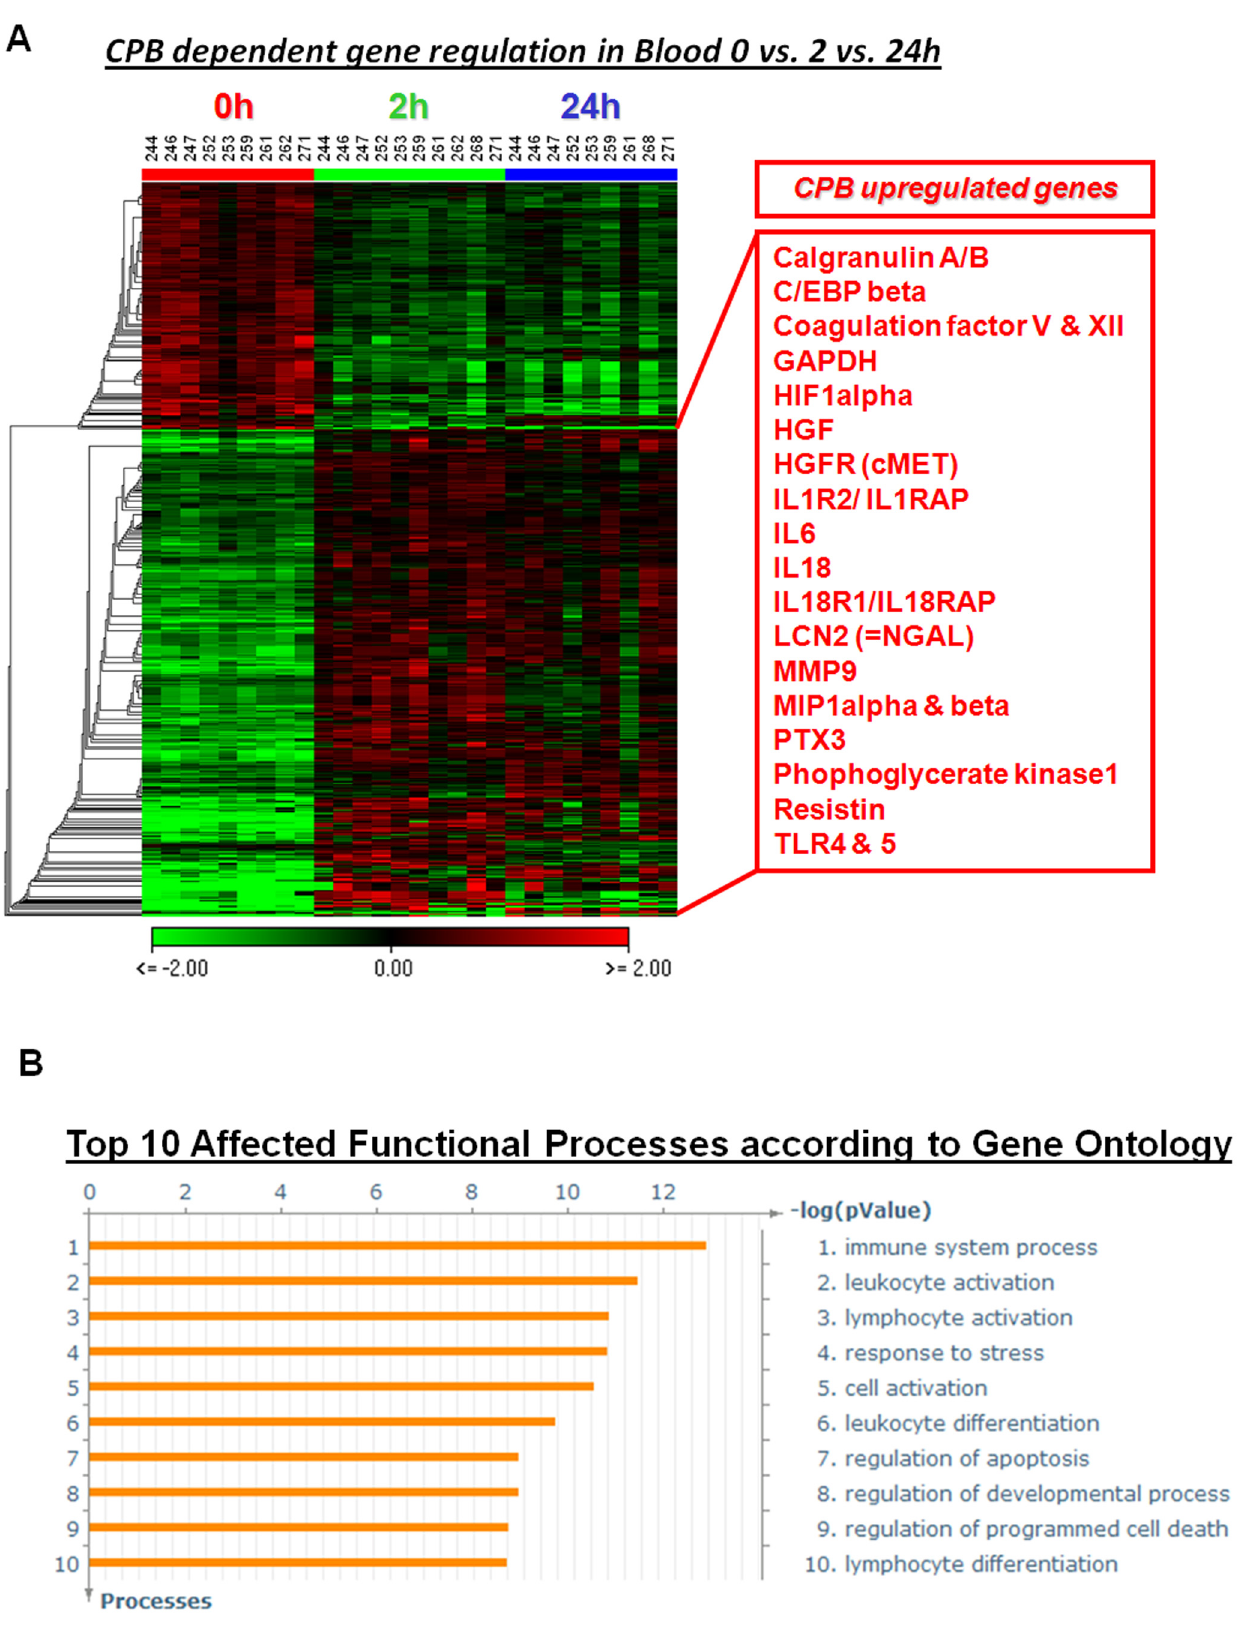
Figure 1. Genome-wide expression profiling. Wholebloodgeneexpressionprofiles ( PanelA ). Whole blood cell expression profiles before (0), 2 h and 24 h post CPB revealed 916 differentially regulated transcripts corresponding to 610 known genes (p , 0.01). The selected sets of genes are presented as a heatmap using hierarchical clustering (HCL) with Euclidean distances and complete linkage analysis (for a detailed gene list see